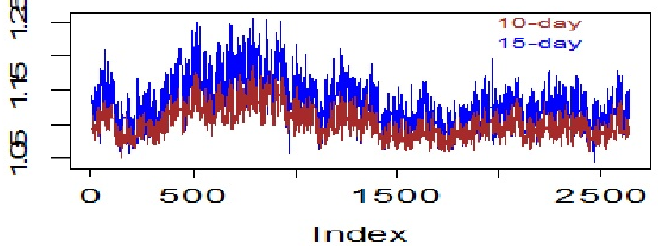
Figure 3. Comparison of 15-day VaR and MaxVaR. Note: The figure shows the 15-day VaR and MaxVaR for the 60-day maturity FTSE 100 index option at a significance level of 2.5%. Residuals are assumed to follow Pearson’s Type IV distribution. Black line indicates the P&L of the FTSE 100 index option.